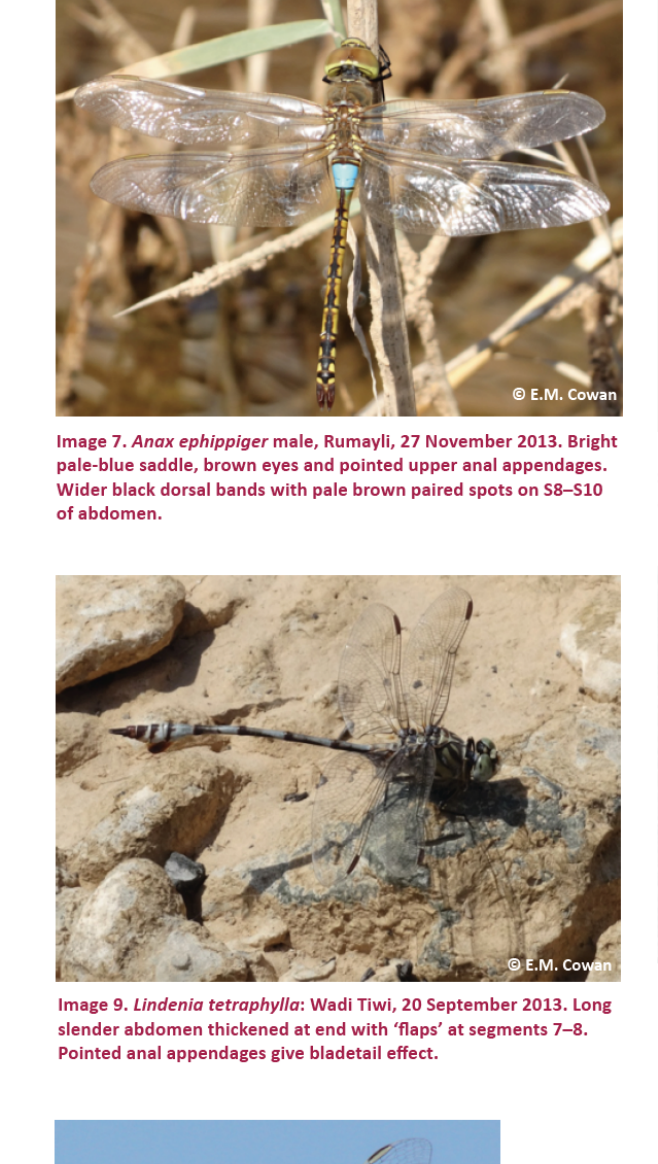
Image 9. Lfindenfia fteftraphyflfla: Wadfi Tfiwfi, 20 Sepftember 2013. Long sflender abdomen fthfickened aft end wfifth ‘flaps’ aft segmenfts 7–8. Pofinfted anafl appendages gfive bfladeftafifl efecft.